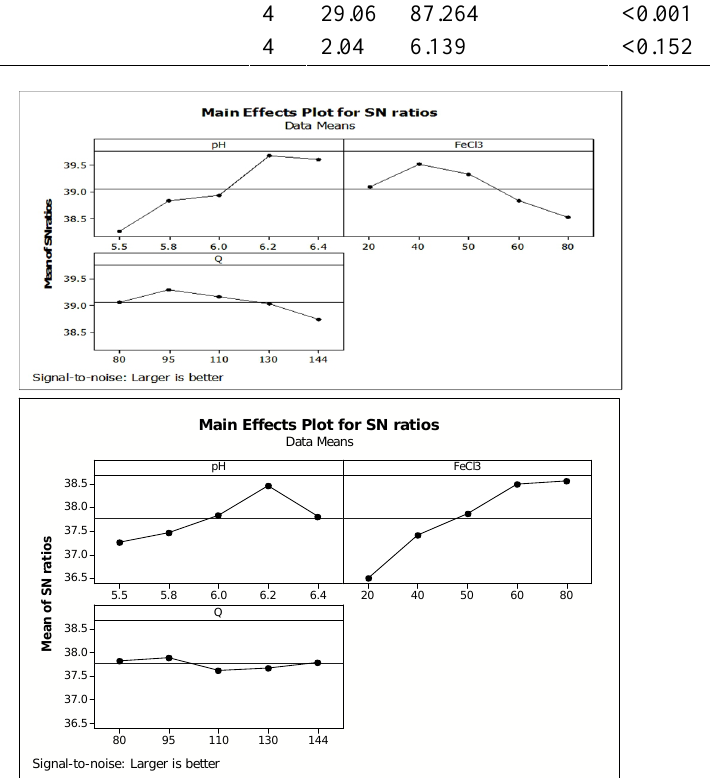
Fig. 2.The mean of signal to noise(S/N) of effluent for pH, coagulant dose and flow rate on the color and turbidity removal (a) and the NOM